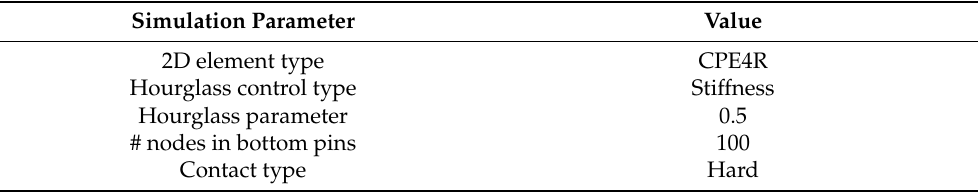
Table 5. Parameters used in all CZS and extended finite element method (XFEM) simulations.